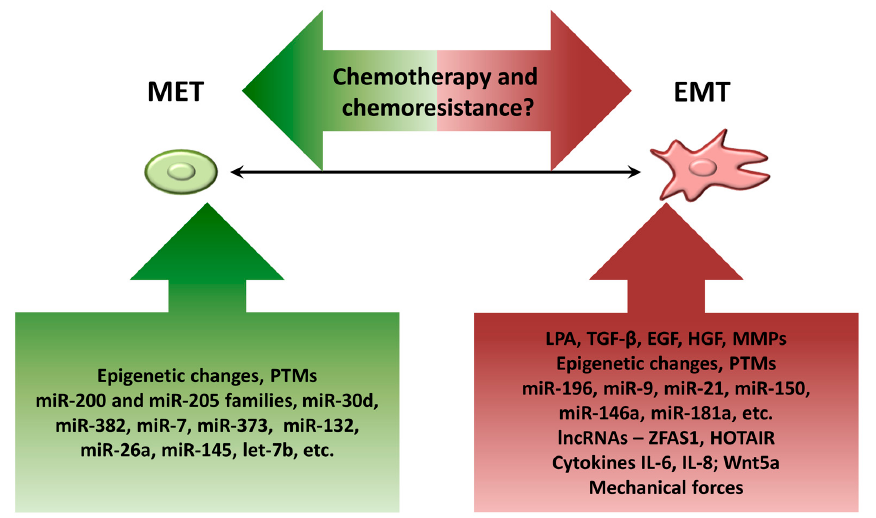
Figure 4. Overview of EMT regulators in ovarian cancer. The diagram summarizes major factors involved in MET (green box) and EMT (red box) programs during EOC progression. The interplay between EMT shifts and ovarian cancer chemotherapy/chemoresistance currently remains controversial.